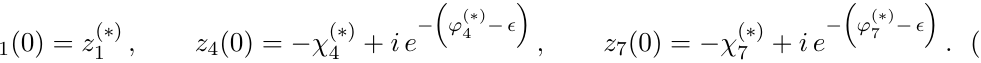
(left), ˜ z (middle) and ˜ z (right). The N = 4 & SO(4) 1 4 7 = 1 . The red flow corresponds 1 | . Black dots in the middle and crit = ˜ z are real-valued, and correspond to 4 7